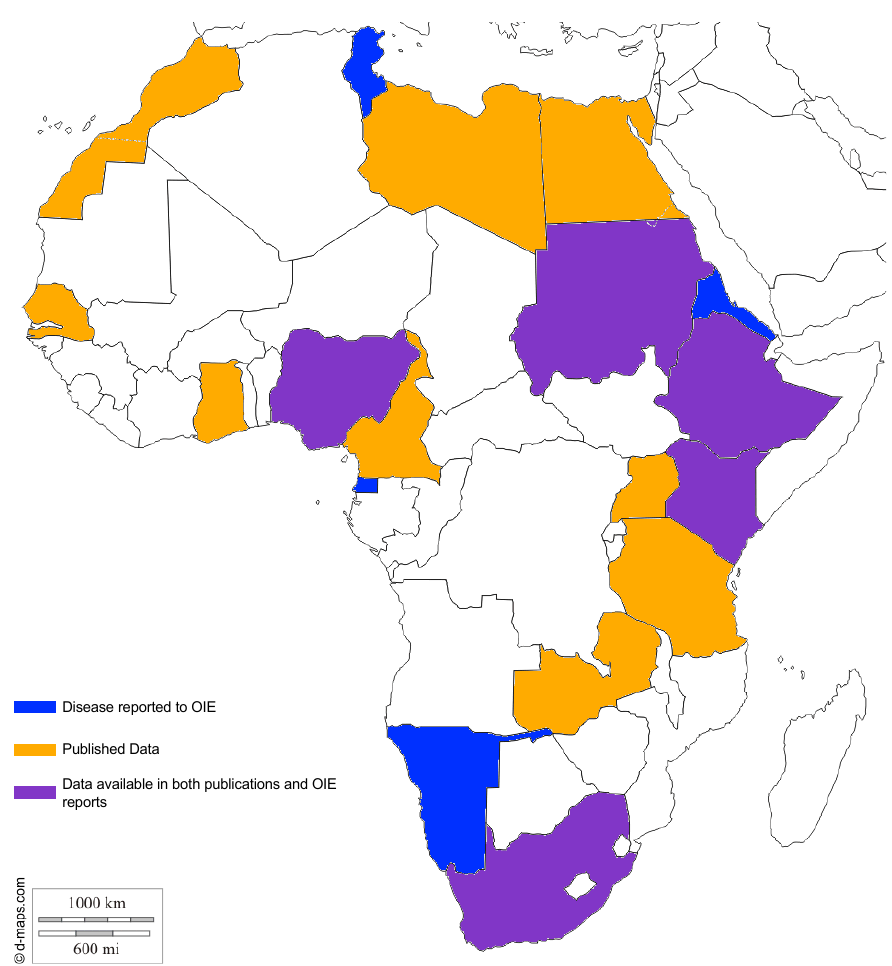
Figure 1. Map of the prevalence of paratuberculosis in Africa as reported to the World Organization for Animal Health, formerly the Office International des Epizooties (OIE) and/or in publications. 80 Table 1. Reports on Mycobacterium avium subspecies paratuberculosis (MAP) in African counties. 81